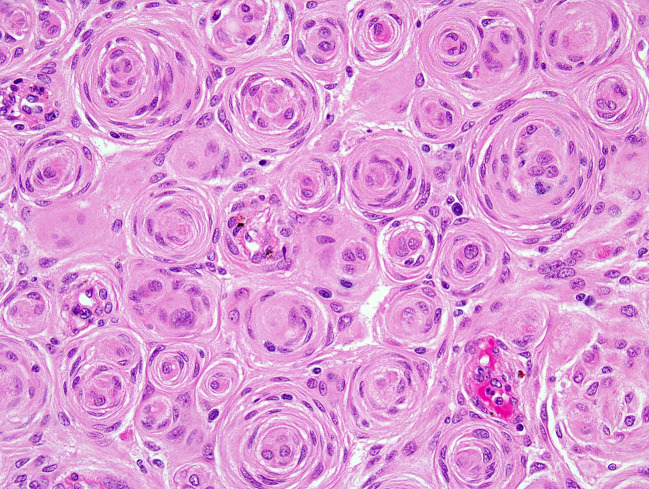
H&E of meningothelial meningioma with prominent whorled architecture (400×; H&E, hematoxylin and eosin stain).